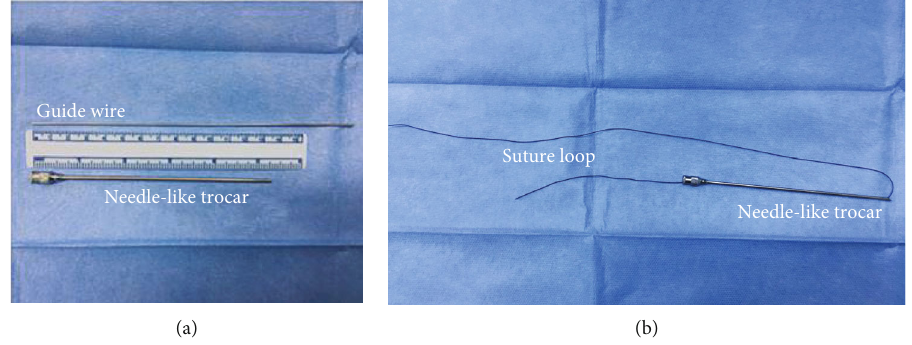
Figure 1: (a) The self-made needle-like trocar and guide wire; (b) needle-like trocar with